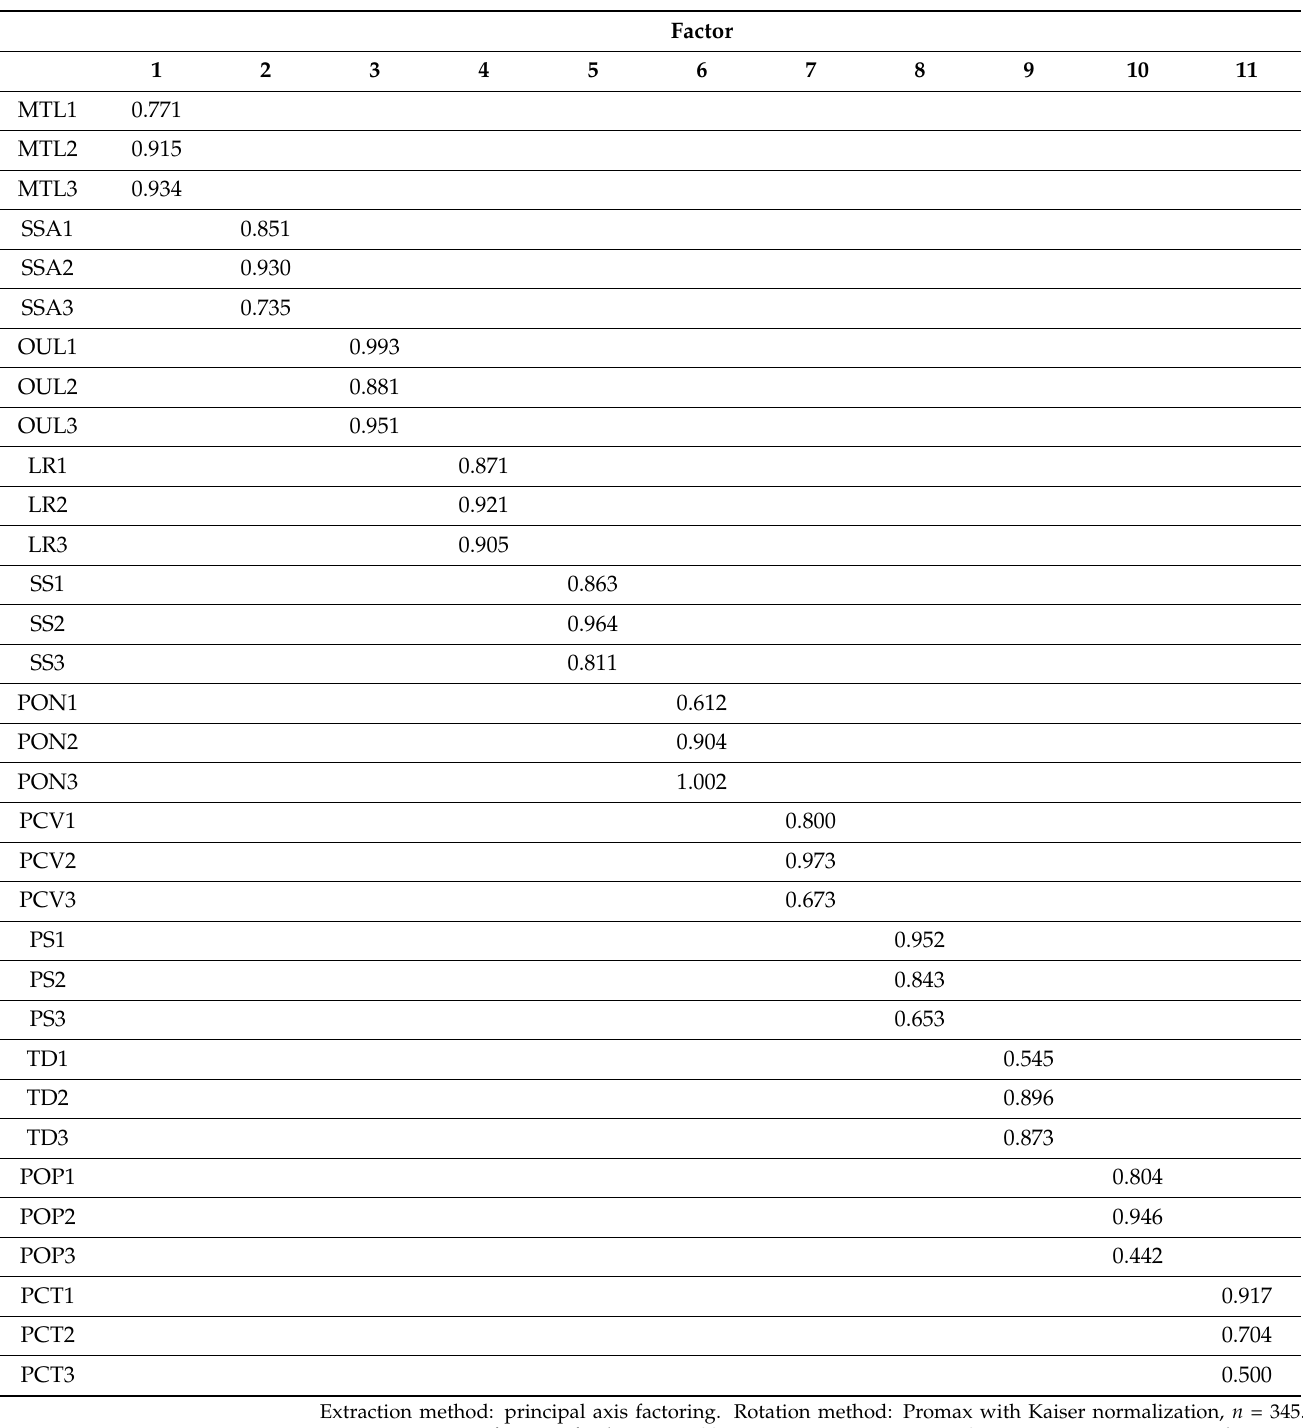
Table 2. Rotated Factor Loading Table for the LTSI Training Specific Domain (11 factors extraction n =